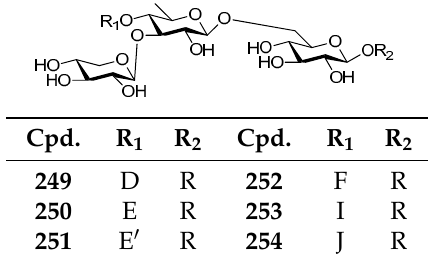
Figure 54. Structures of compounds 249 – 254 .